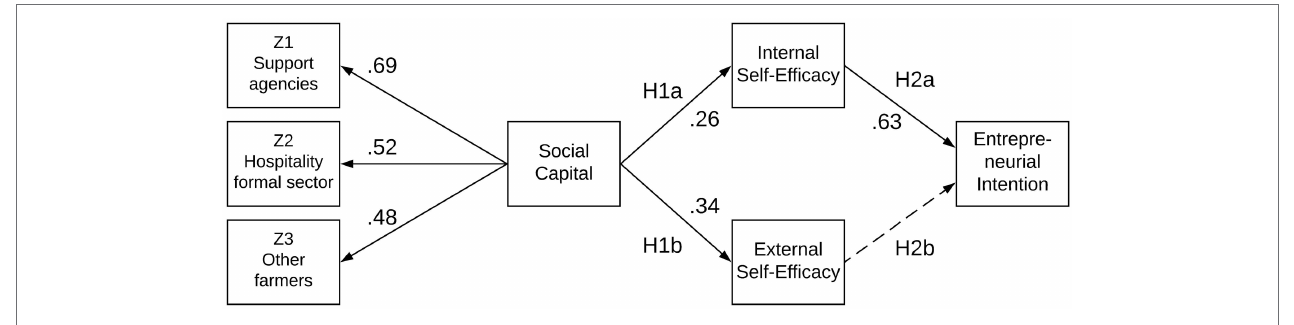
FIGURE 4 | Structural equation model.